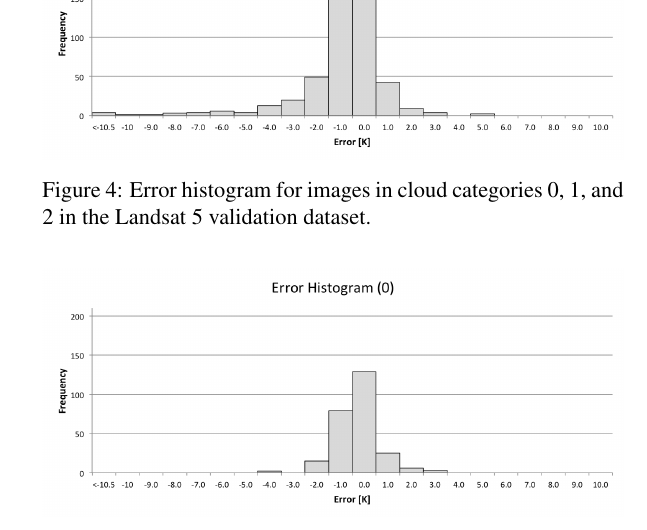
Figure 5: Error histogram including only scenes categorized as cloud free (0) from the Landsat 5 validation